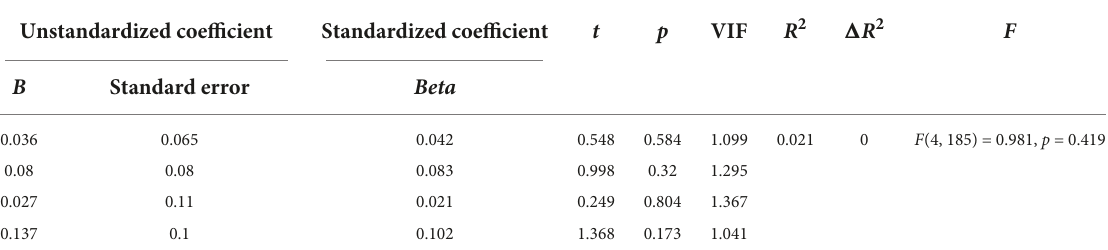
TABLE 1 Linear regression analysis results ( N =